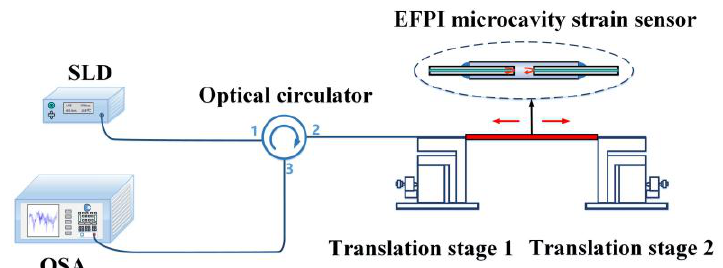
Figure 2. Schematic of a strain sensing system based on the EFPI microcavity strain sensor (SLD: superluminescent diode, OSA: optical spectrum analyzer). The SLD is used as a wideband illuminating source. The OSA is used to extract the reflection spectrum. Two capillary ends of the EFPI microcavity strain sensor are fixed on a pair of translation stages for strain imposing test.